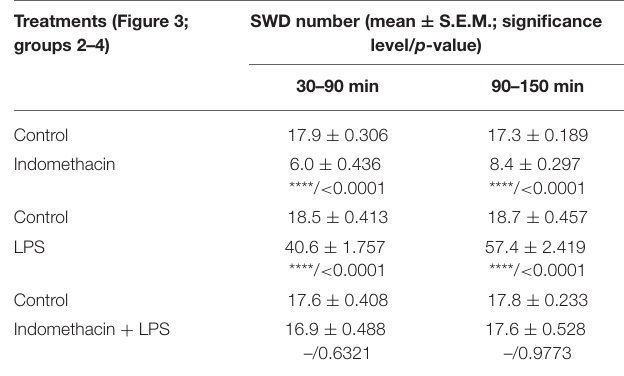
TABLE 4 | Effect of KEKS food (20% KEKS and 1% saccharin in standard rodent chow; group 1) on blood β HB and glucose levels. Treatments (group 1)